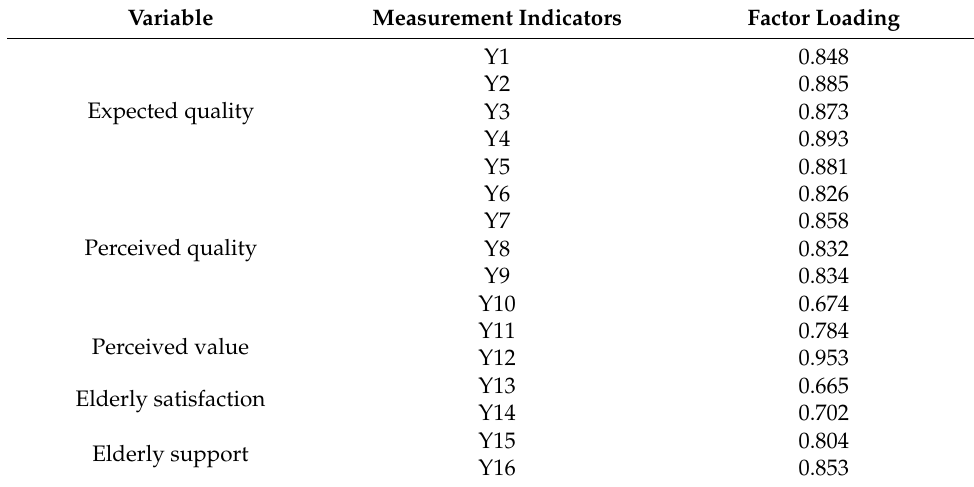
Table 6. Factor loading detection.